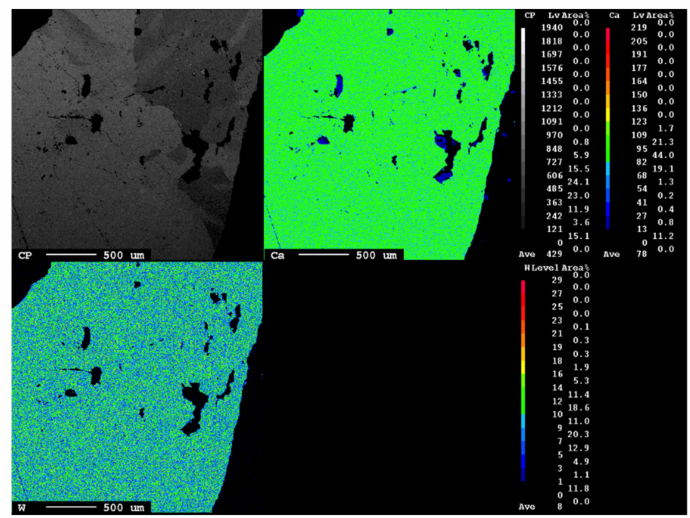
Figure 4. X-ray maps of W and Ca distribution in scheelite (reproduced from Bobos et al. [28] with permission of the Mineralogical Society of Great Britain and Ireland).